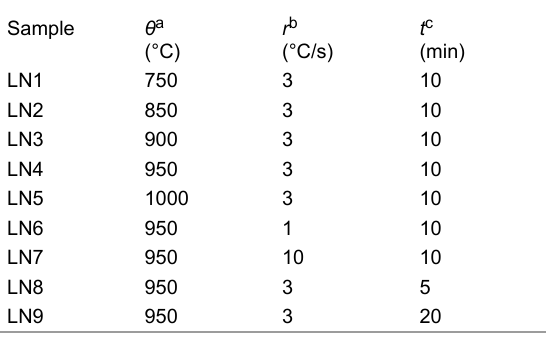
Table 2: Reaction conditions of as-prepared LiNbO 3 /SBA-15 compos- ites (LN).